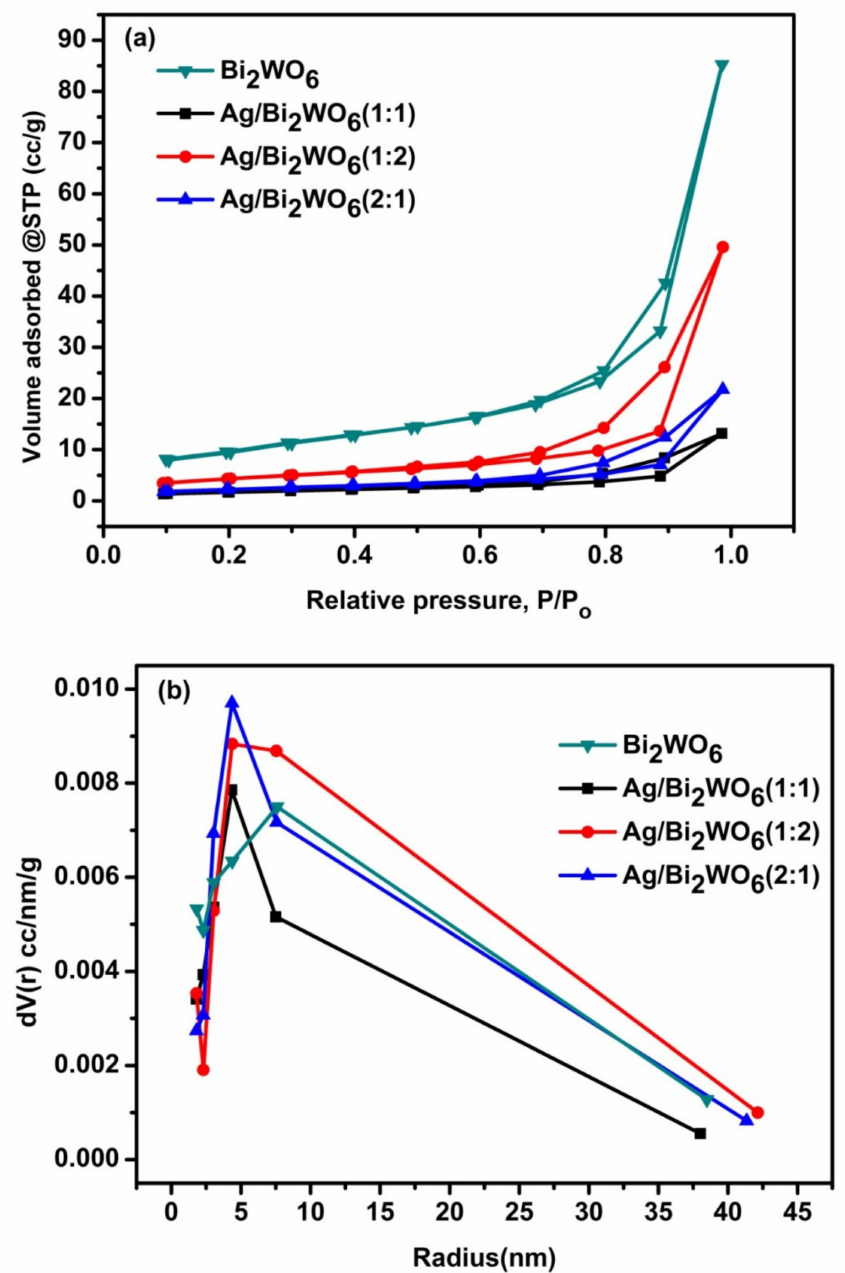
Figure 10. ( a ) N 2 adsorption–desorption isotherm. ( b ) Pore size distribution of pure Bi 2 WO 6 and Ag/Bi 2 WO 6 (1:1, 1:2 and